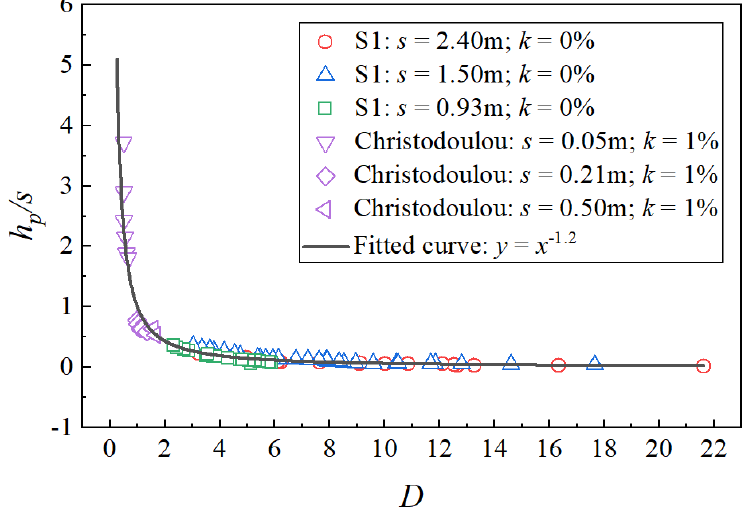
Figure 5. Dimensionless water level versus drop parameter for D M = 0.05 m, 0.21 m and 0.50 m.